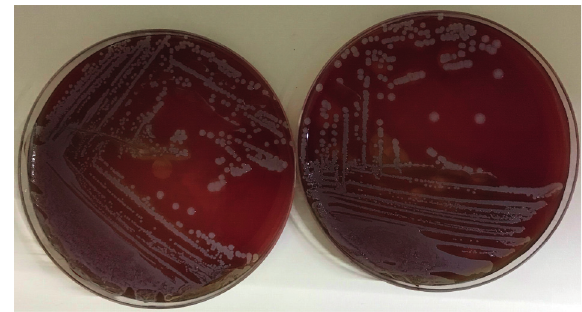
Figure 1: Staphylococcus aureus on blood agar. Table 1: Antibiogram from Staphylococcus aureus strains.